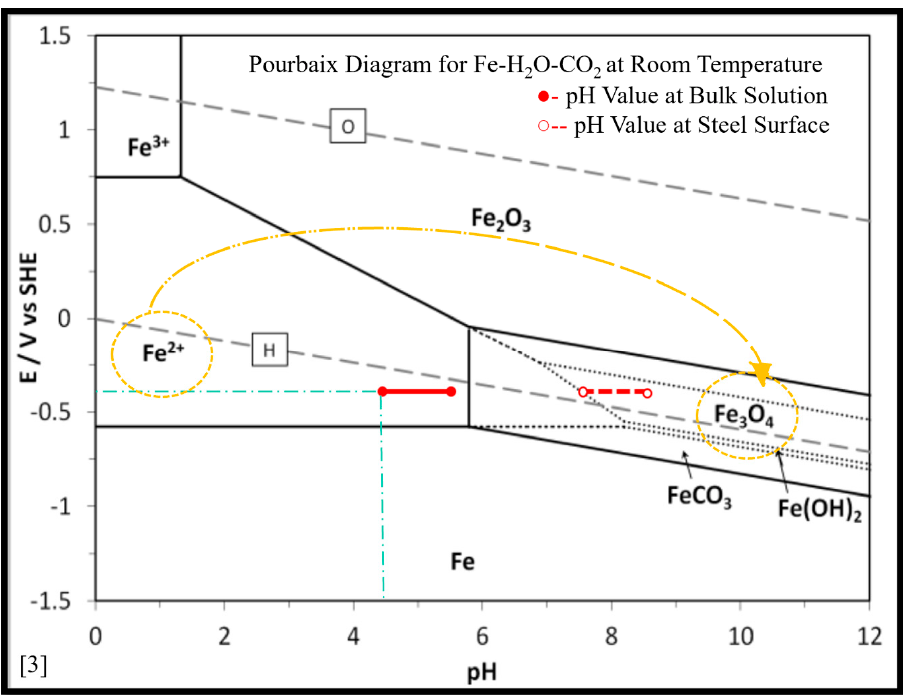
Figure 6. Pourbaix Diagram for Fe–H 2 O–CO 2 at room temperature, cfe 2+ = 10 ppm, cfe 3+ = 10 ppm, hydrogen partial pressure 1 bar, oxygen partial pressure 1 bar, carbon dioxide partial pressure 1 bar (symbols: ● - pH value at bulk solution, ○ -- pH value at steel surface) [26].